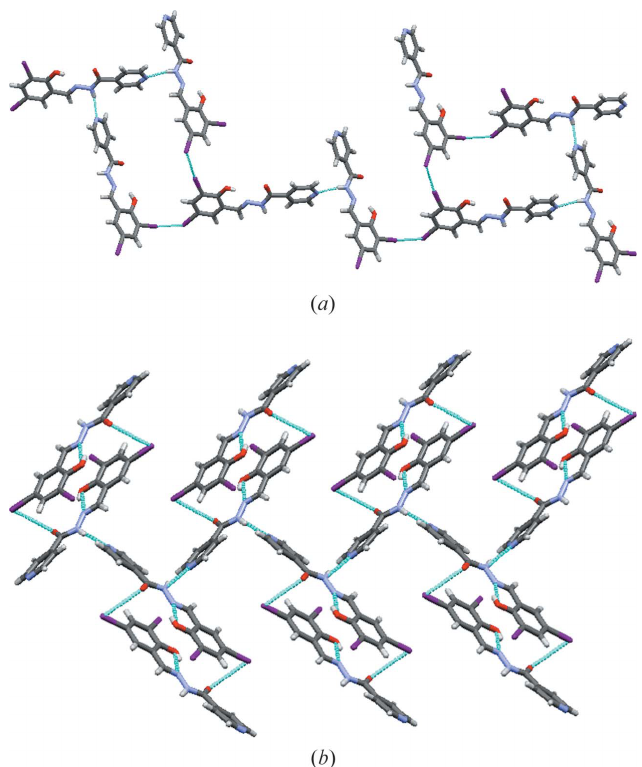
Figure 6 ( a ) Type II (I (cid:2)(cid:2)(cid:2) I) halogen bonding of Compound-D. ( b ) The dimers extended via N—H (cid:2)(cid:2)(cid:2) N hydrogen bonds